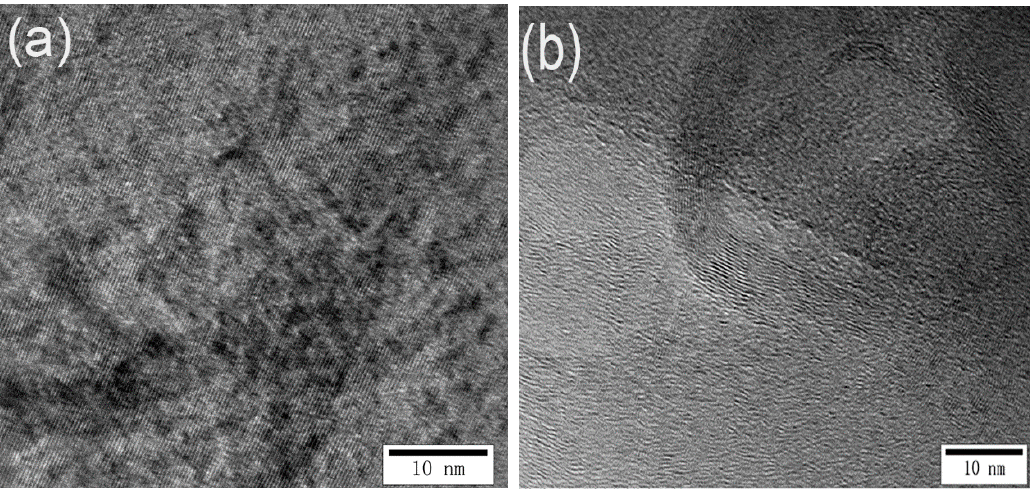
Figure 3. HRTEM image of carbon cathodes at testing 20 min with various current densities (a) 0.45 A/cm 2 (b) 0.7 A/cm 2 .